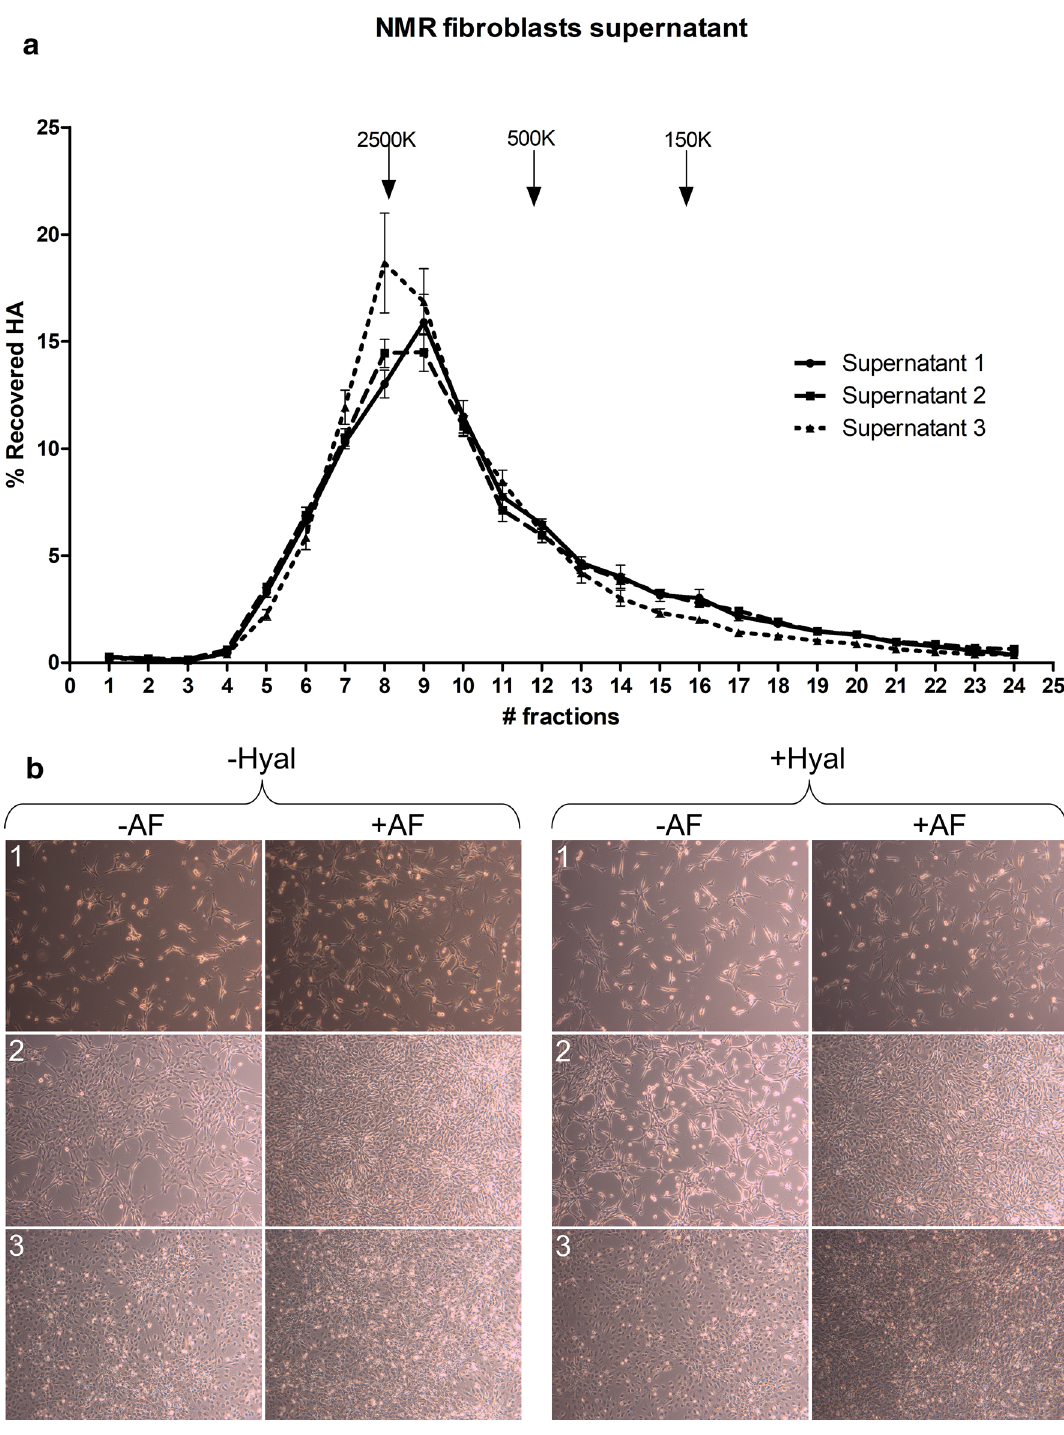
Figure 7. NMR fibroblast culture. ( a ) HA size distribution in NMR fibroblasts supernatant at 3 different times: days 3, 6, and 9, represented by supernatants 1, 2, and 3, respectively (n = 4 cultures for each condition). ( b ) NMR fibroblast culture treated with (+) and without (−) 3 U/ml hyaluronidase from Streptomyces hyalurolyticus in the culture media, and with (+) and without (−) attachment factor